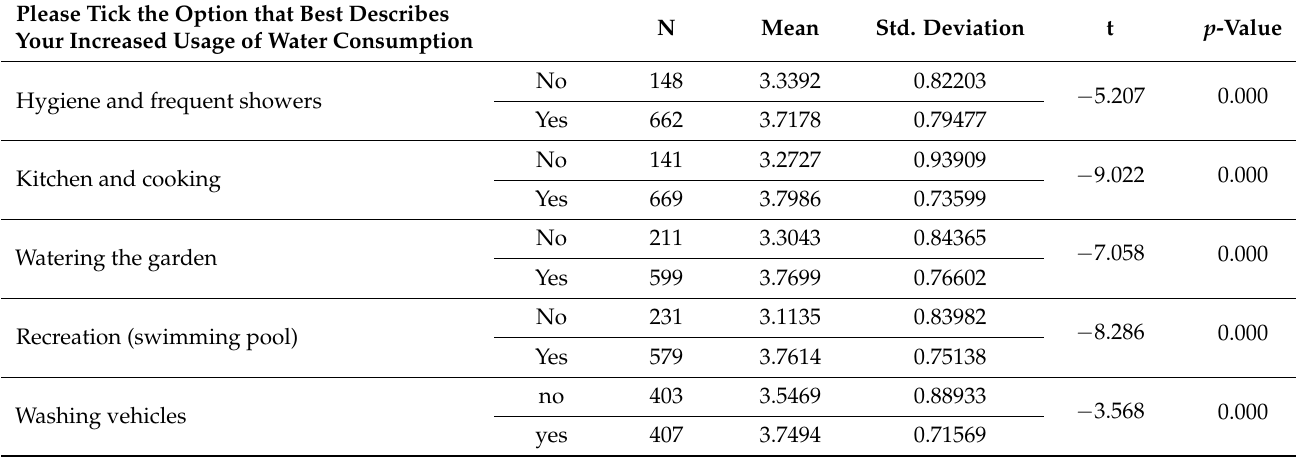
Table 5. T -test for significant differences in water-use behavior based on ways in which water usage increases.